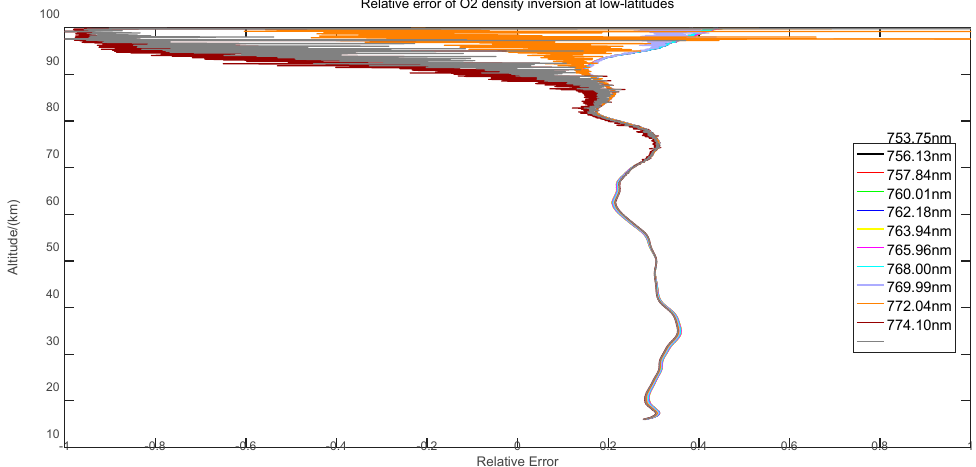
Figure 6. Absolute deviation of oxygen number density retrieved by different wavelengths.